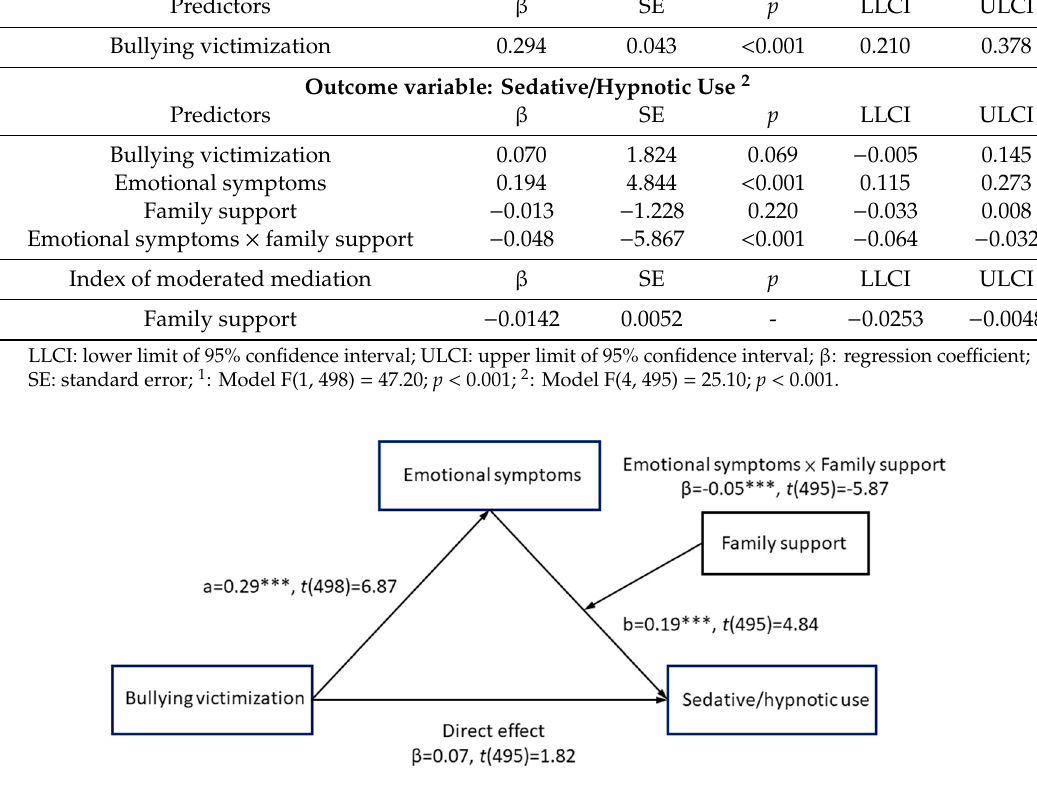
Figure 2. Final model indicating the co-e ffi cient estimates and statistical